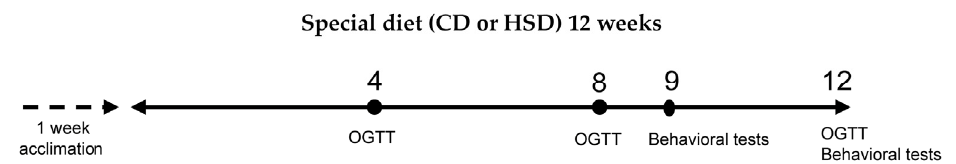
Figure 1. Experimental flow